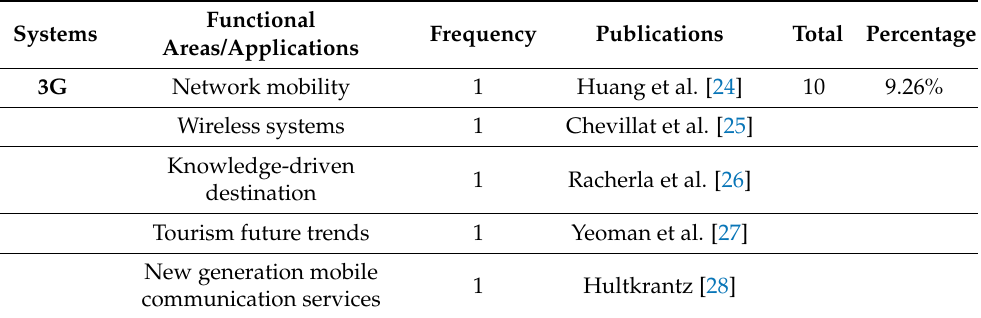
Table 3. Functional areas or applications of mobile communication technology in hospitality and